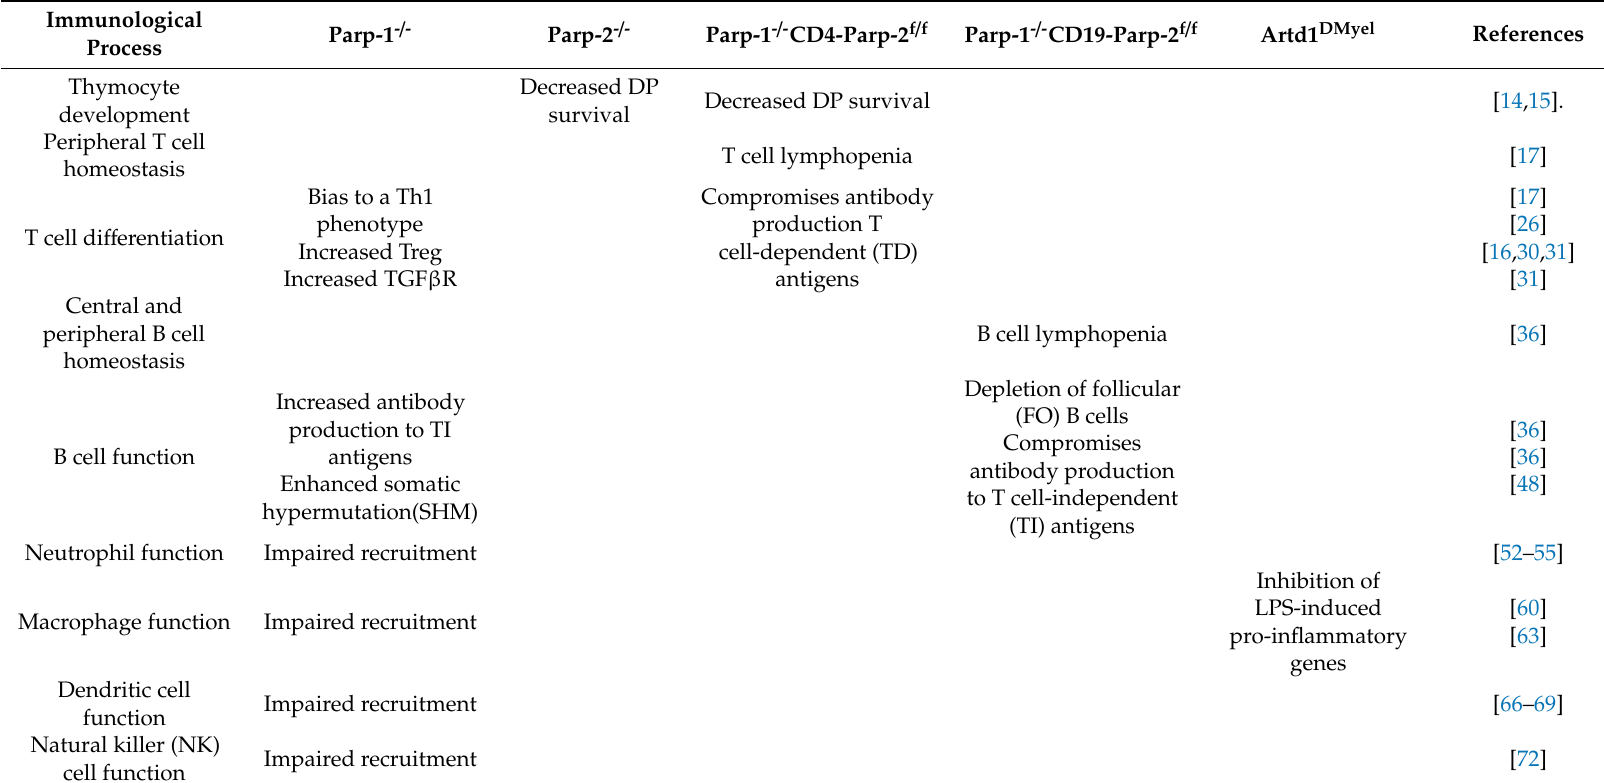
Table 1. Immunological phenotypes in PARP-1- and / or PARP-2-deficient mouse